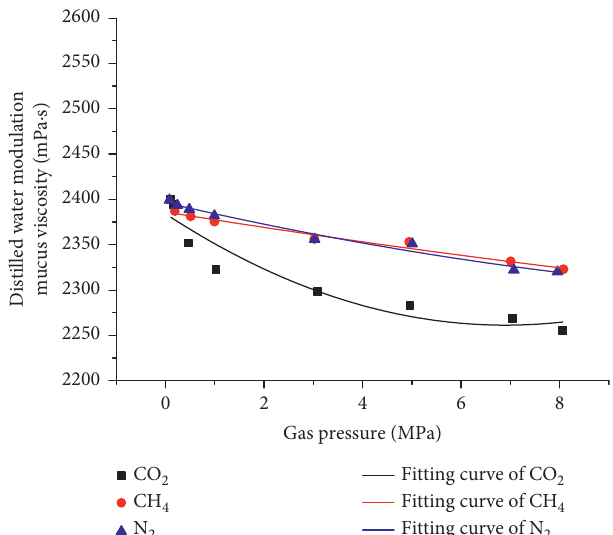
Figure 7: Curve of the viscosity of CMC-Na prepared using distilled water at different Table 4: Fitting formula of the viscosity of CMC-Na prepared using groundwater at different pressures. Project